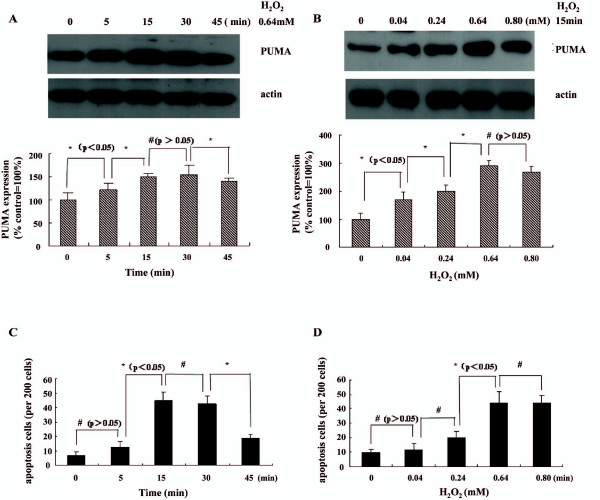
H2O2 induced PUMA expression and apoptosis in a time-and dose-dependent manner in colorectal cancer cells. (A) LoVo Cells were treated with 0.64 mM H2O2 at different time point and PUMA expression was assessed by Western blotting analysis. (B) Western blotting analysis of a dose-range of a 15 minute H2O2 exposure of LoVo cells. Data was presented as the percentage of the basal level of PUMA expression (control = 100%) in the absence of H2O2 and expressed as mean ± SD of three independent experiments. (C, D) LoVo Cells were treated with a time- and dose- range of H2O2 as indicated in Figure 1C, D, apoptosis was assessed by Hoechst dye 33258. Data was presented as the number of apoptosis per 200 cells in three different areas. Statistical significance as compared to control cells (*p < 0.05, #p > 0.05).